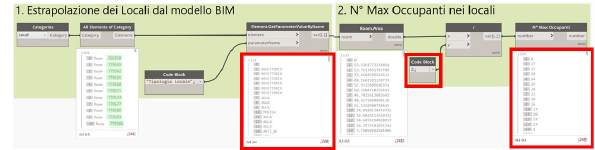
Figure 7. The script for the query focused on school strategic organization: Automatic selection of rooms of the school for calculation of the maximum capacity